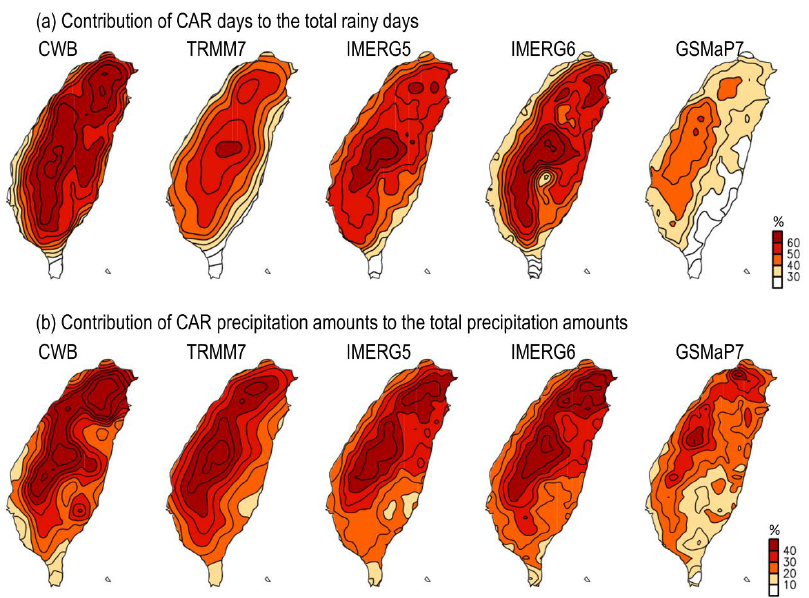
Figure 7. ( a ) Infrared cloud image, obtained from Gridded Satellite B1 Observations (https://www.ncdc.noaa.gov/gridsat/), for an example of convective afternoon rainfall (CAR) event that occurred on 20 June 2016, 17 h (local time) in Taiwan. ( b ) Time series of hourly precipitation (bars) and surface temperature (Ts, red line) averaged from local stations in Taiwan for the event shown in ( a ).